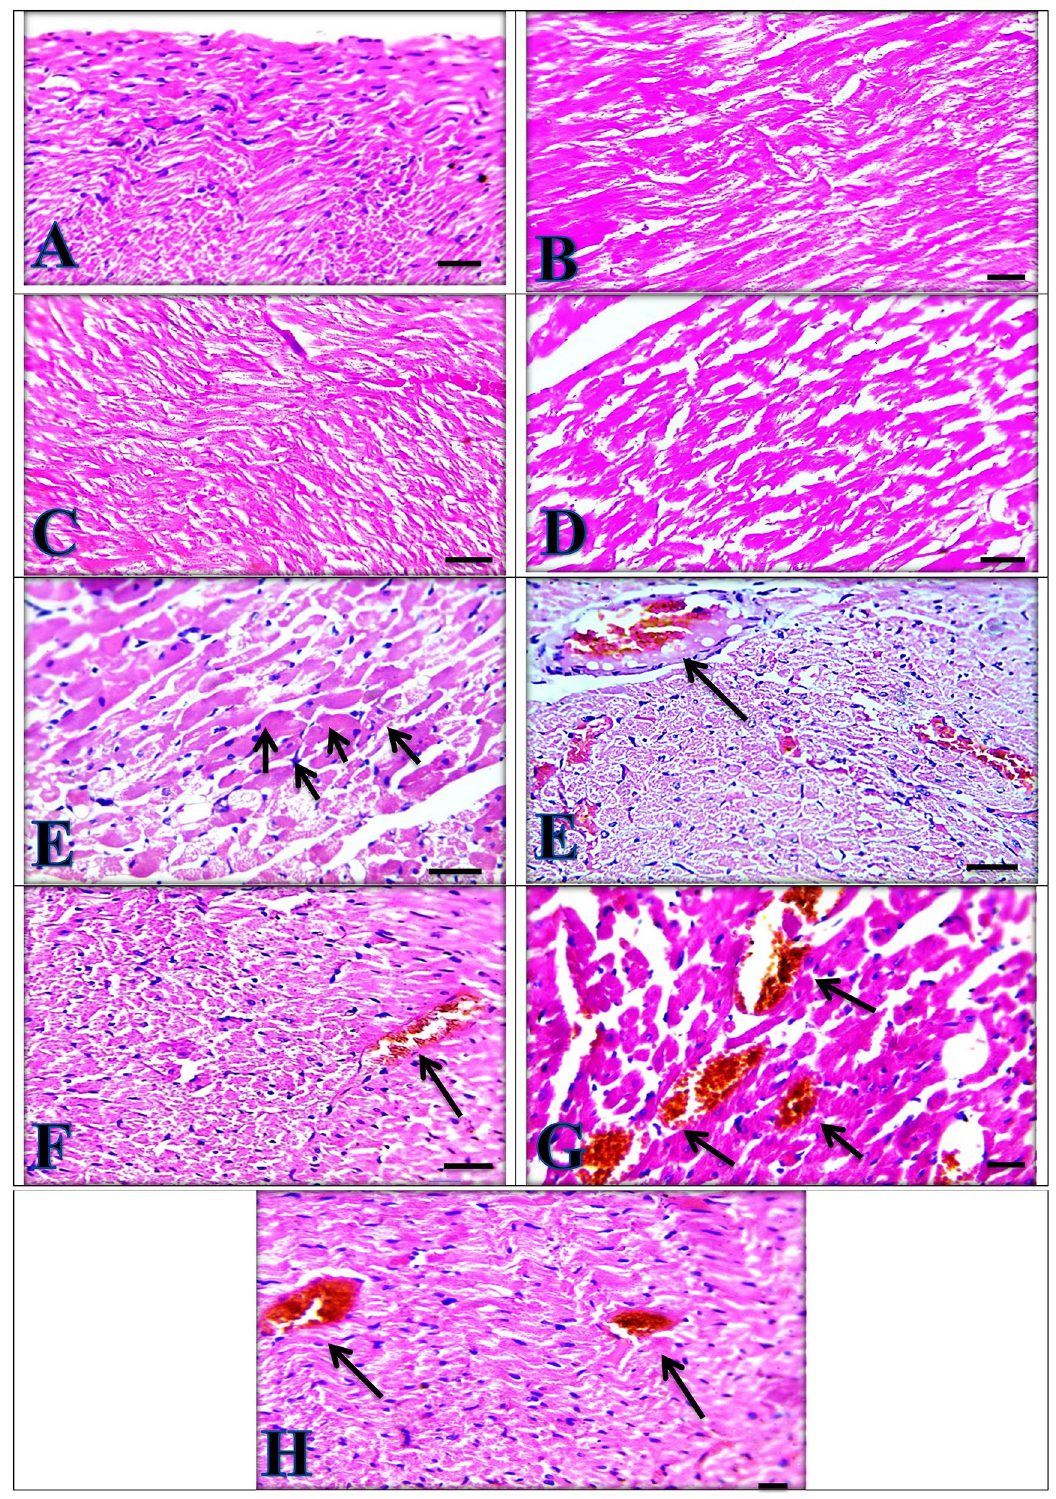
Figure 6. Heart sections showing normal appearance in ( A ) Control group, ( B ) Silymarin group, ( C ) Chlorella vulgaris group ( D ) Chlorella vulgaris + Thiamine group . ( E ) Paracetamol group showing severely congested cardiac blood vessels (arrows) besides degeneration and vacuolation in cardiomyocytes (arrowheads). ( F ) Silymarin + Paracetamol group and ( H ) Chlorella vulgaris + Thiamine + Paracetamol showing mildly congested cardiac blood vessels (arrows). ( G ) Chlorella vulgaris + Paracetamol group showing moderately congested cardiac blood vessels. ( H ) and ( E ) X: 400 bar